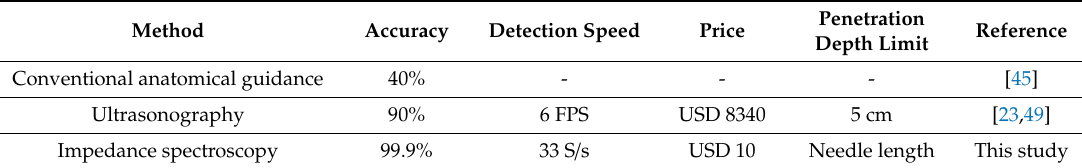
Table 2. Comparison of the fabricated impedance-based algorithm’s performance with the existing available